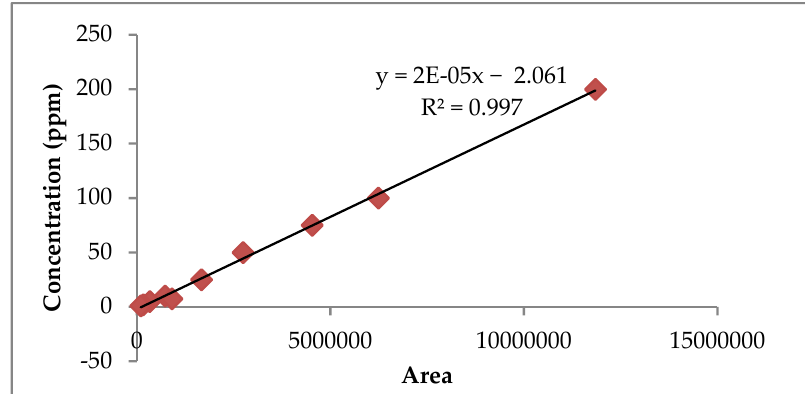
Figure 3. Calibration curve for standard pelargonidin 3,5-di- O -glucoside.